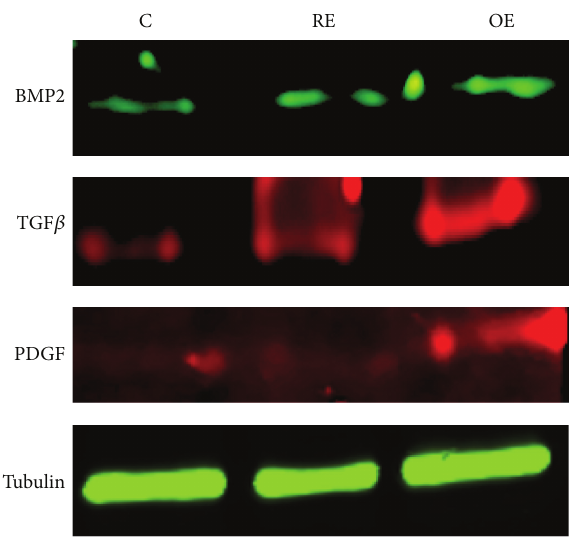
Figure 2: Immunoblotting experiments: images are representative immunoblots of BMP2, TGF 𝛽 , PDGF, and tubulin (top to bottom). Note the increase in expression of the growth factors between control and exosome treated samples. Tubulin was used as loading control.